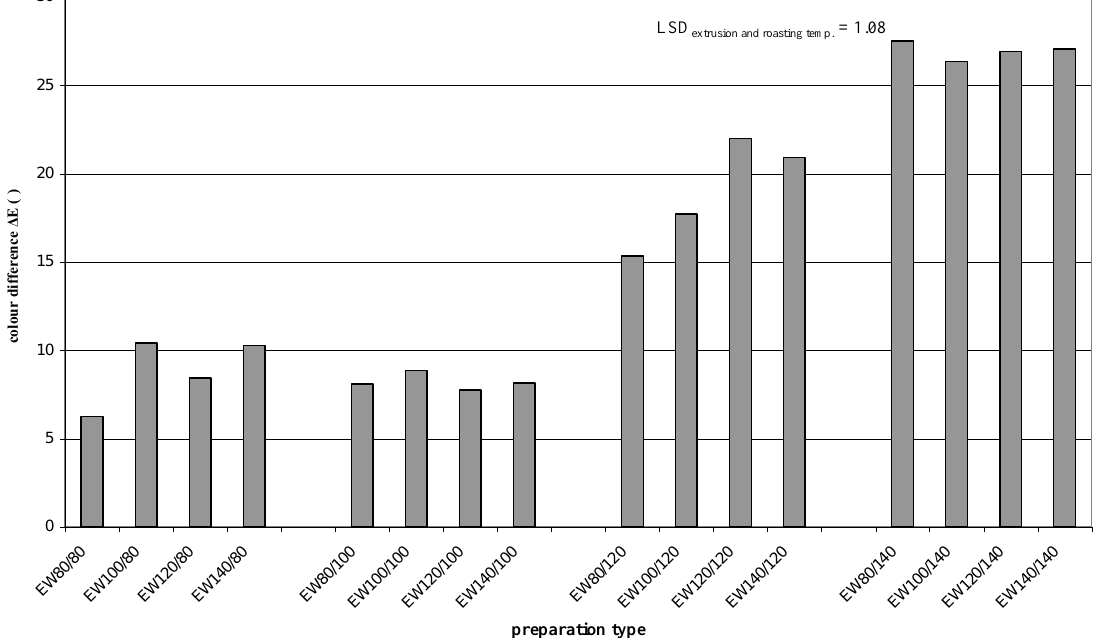
Figure 4. Color difference ∆ E of esters produced by starch extrusion with apple distillery wastewater and roasting (EW). The resistance of extruded and roasted starch (E) to the action of amyloglucosidase increased from ca. 14 to 17 g/100 g on average along with the increasing extrusion and roasting temperatures. It was due to the re-polymerization occurring during the heat- treatment of the starch [1,43] (Figure 3). The esterification process (EW) caused an increase in the enzymatic resistance of the starch, with an analogous tendency of changes. The starch esters produced via the extrusion of native potato starch with apple distillery wastewater and roasting revealed high resistance, ranging from ca. 30 to over 41 g/100 g. The starch extruded and roasted at 100 C was characterized by both high enzymatic re- sistance (ca. 31 g/100 g on average) and the relatively high viscosity of its pastes in the entire course of the flow curves. Due to these properties, it can presumably find applica- tions as a novel type of resistant starch with texture-forming properties. The chemical processes employed in food technology include those that are based on chemical reactions that require using certain chemical substances and proceed without a biological factor [44]. Only selected modified starches are permitted for use in food pro- duction. They are treated as food additives and denoted with the symbol ‘E’ and a respec- tive number on food labels [45]. In the present study, a natural waste product from the production of dry calvados was used as a novelty in the starch modification process. The study concerned the chemical transformations of potato starch under the influence of or- ganic acids naturally occurring in apple juices during their heat treatment. As a result of these transformations, starch esters were obtained whose main property was the high re- sistance to the action of amylolytic enzymes. 4. Conclusions The extrusion and roasting of potato starch with acids contained in the raw material derived from apple distillery wastewater allowed the production of starch esters substi- tuted with malic acid residues. The degree of starch esterification was higher on average upon the use of higher roasting temperatures. The extrusion of starch followed by its roasting with apple distillery wastewater caused its darker color, its increased resistance to amylolytic enzymes, and its lower solubility compared to the starch roasted without